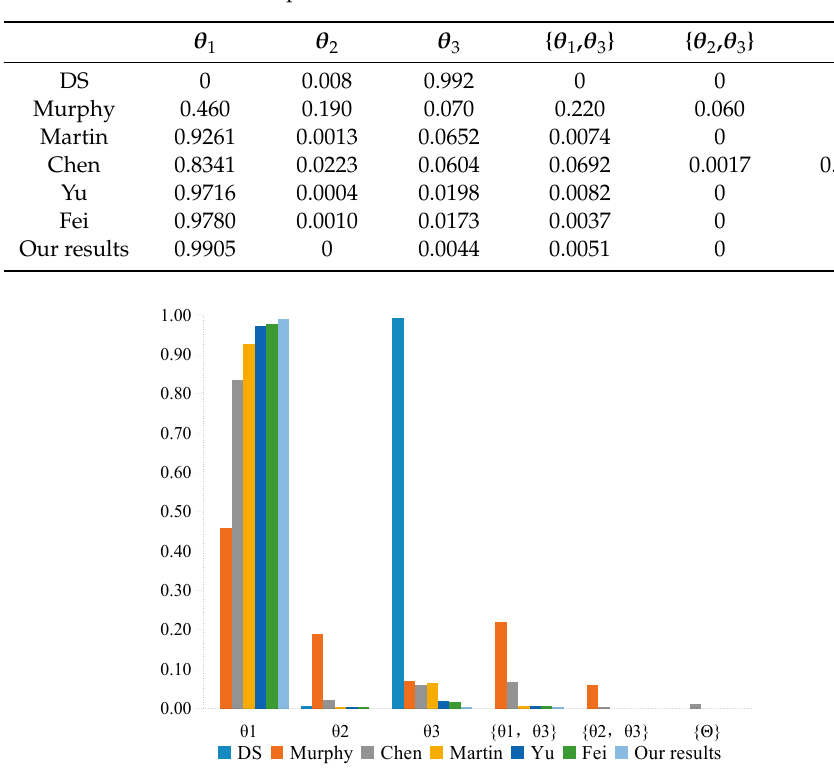
Table 6. The comparison of the fusion results with different methods.